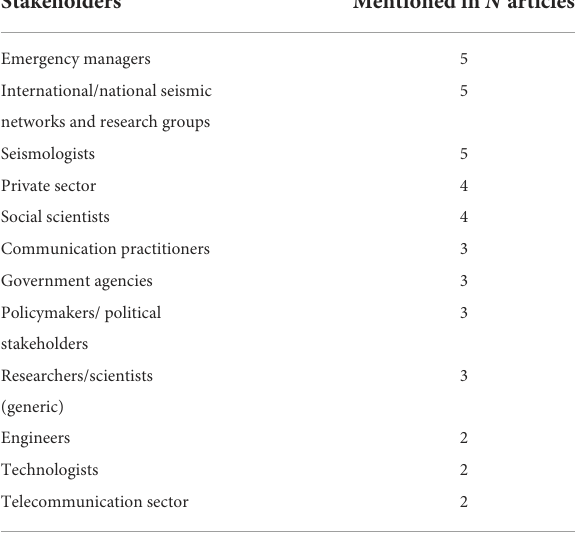
TABLE 5 EEW Stakeholders identified by the